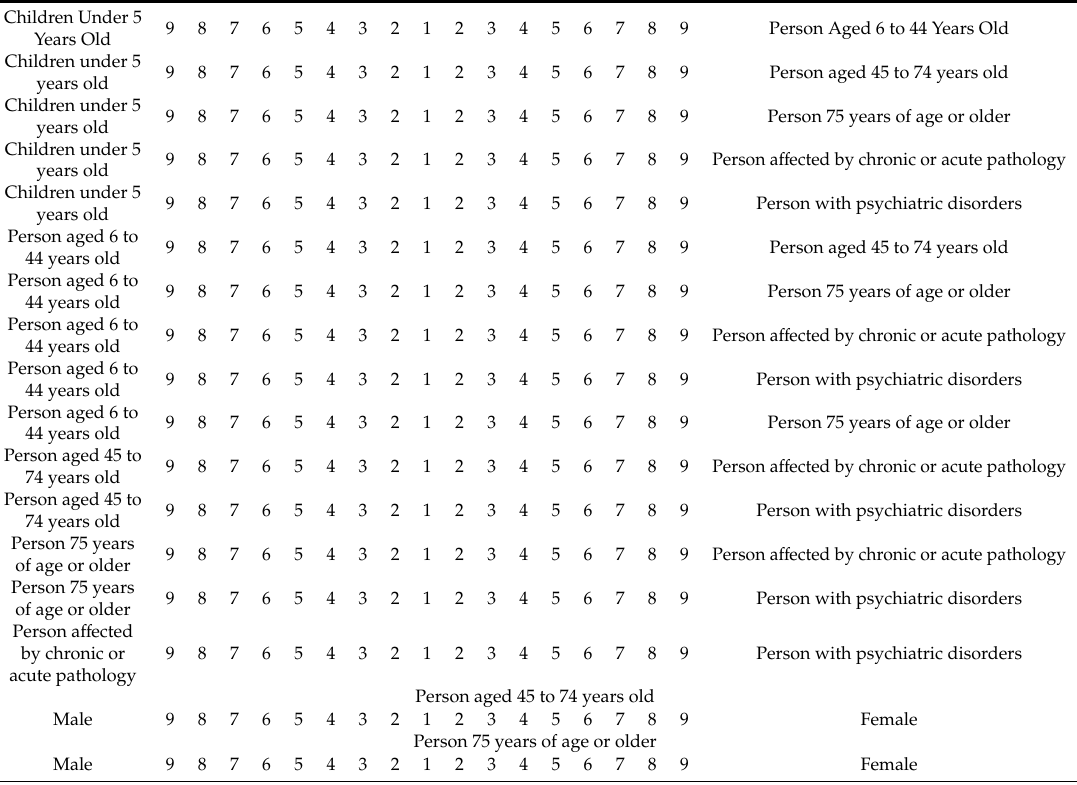
Table 2. Questionnaire completed by the health experts